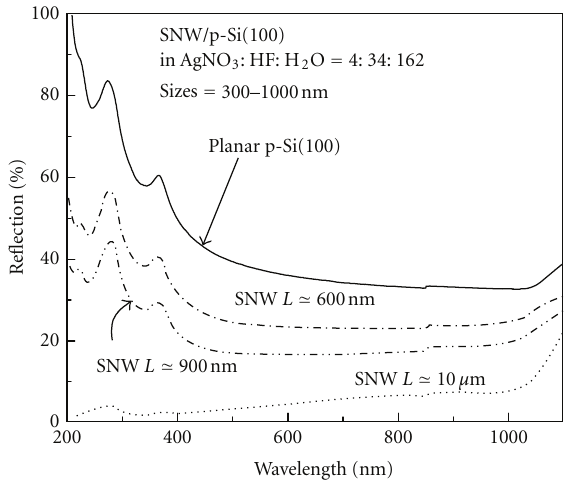
− 1 − 0 . 5 0 0.5 2.5 hr η = 4 . 1% Figure 8: Current density-voltage ( J-V ) curves of various dark and illuminated (AM 1.5) RJSNW solar cells. Etching conditions were aqueous AgNO 3 /HF/H 2 O mixture chemical solution in a ratio of 4:34 :162 (volume) at 25 ◦ C for (a) 1.5, (b) 3, and (c) 30 min. Lengths and cross-section sizes of SNW arrays were 600 nm and 300–1000 nm, respectively. SNW/p-type Si(100) structures were formed by di ff usion of phosphorus at 950 ◦ C for 2.5, 3, 4, and 5hrs, respectively.